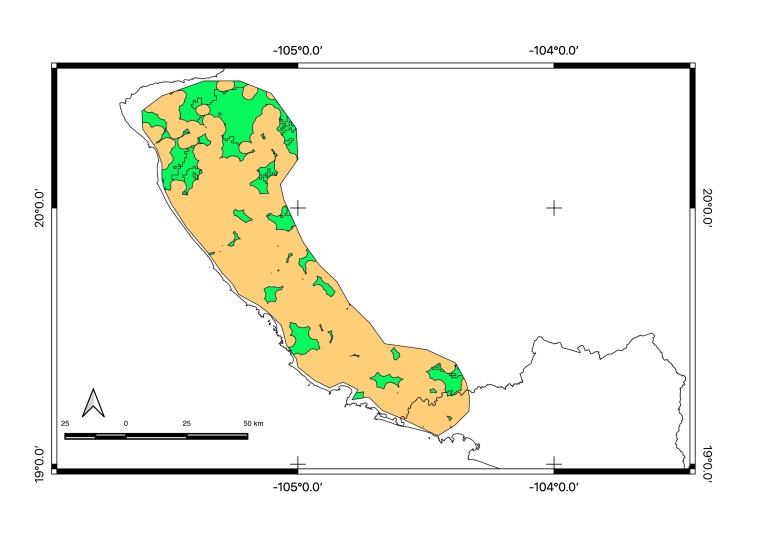
Habitat quality across the distribution of Brachypelma
klaasi (Schmidt & Krause, 1994). Low quality habitat areas (LQH) in orange and high quality habitat areas (HQH) in green (for estimation details, see formula in Methods).